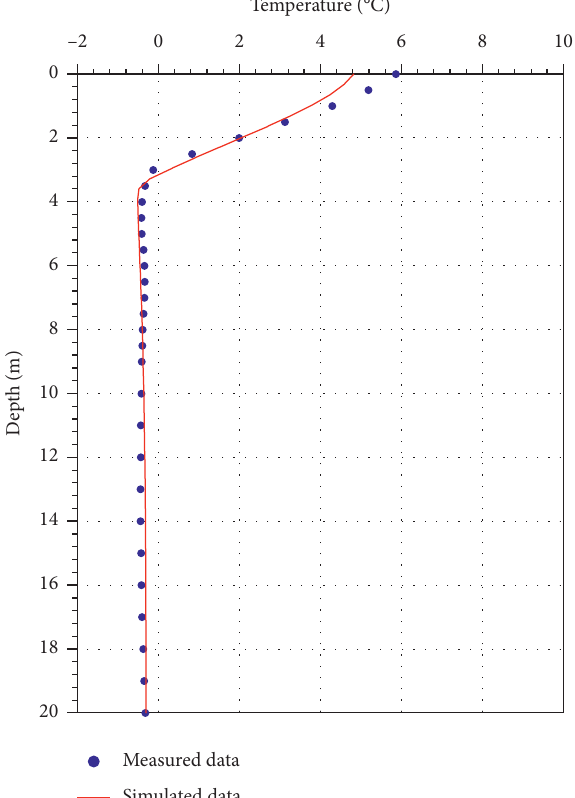
Figure 3: Field observed and numerical simulated ground temperatures vs depth at ST on October 15, 1 st year after the excavation of the channel.